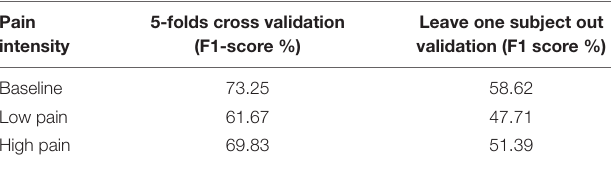
TABLE 3 | The results of the two validation strategies for the pain intensity